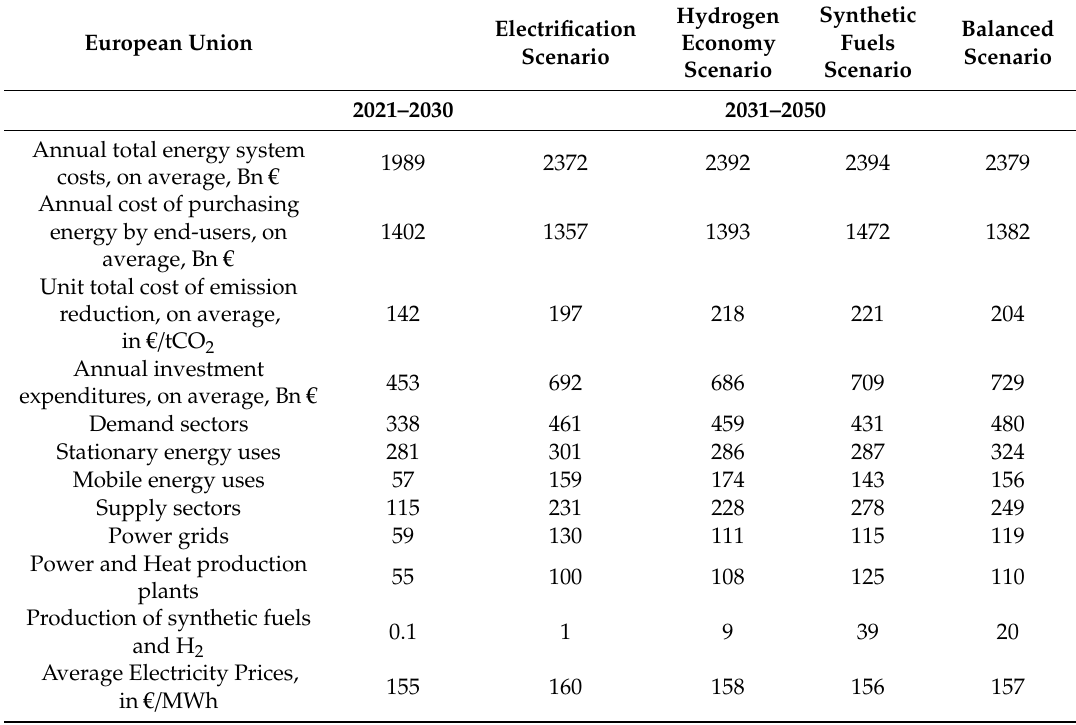
Table 10. Average annual total system costs, purchasing energy, investment expenditures and average electricity